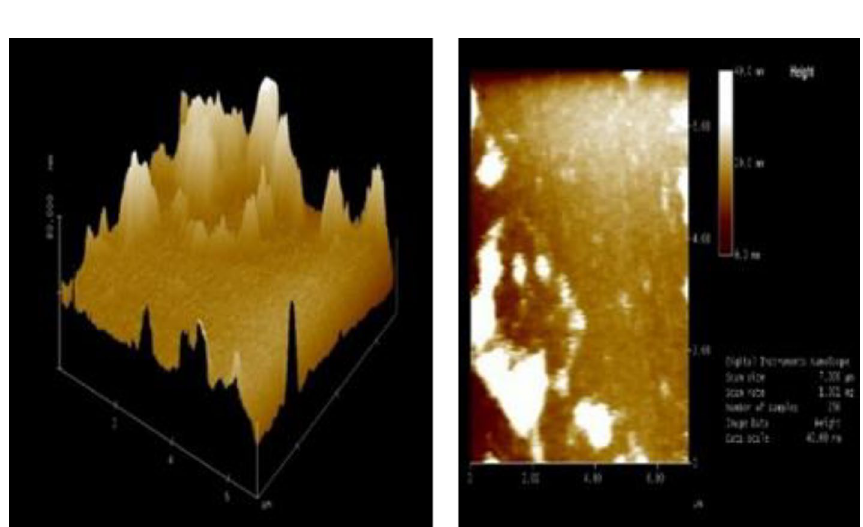
Figure 5. Atomic force microscopy (AFM) of the ball-milled seashells nano-biocomposite ( 3 ).